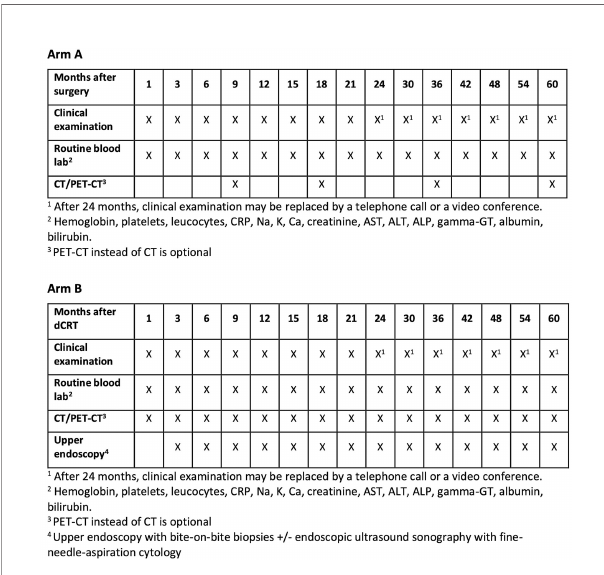
FIGURE 2 | Overview of scheduled cancer recurrence surveillance by treatment